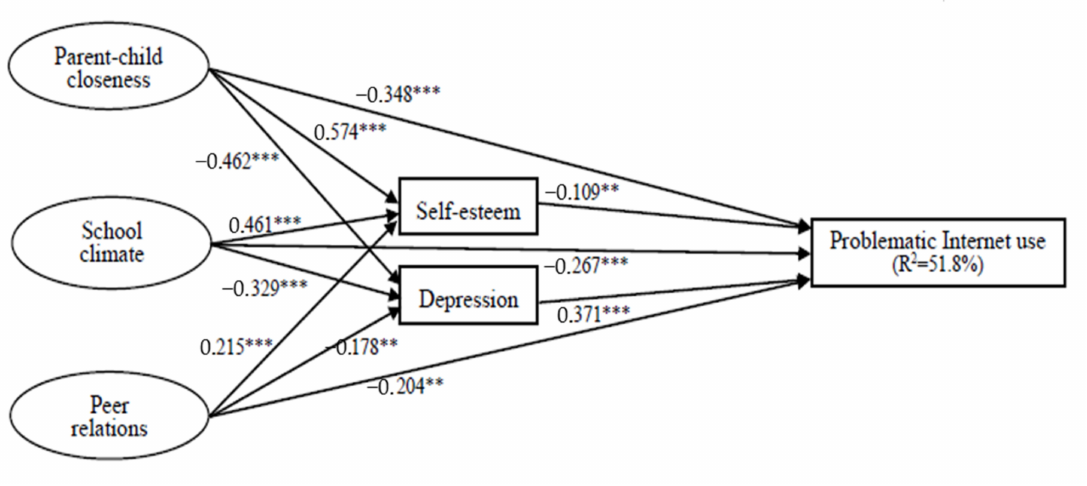
Figure 1. Overall structure equation model (*** p < 0.001; ** p <